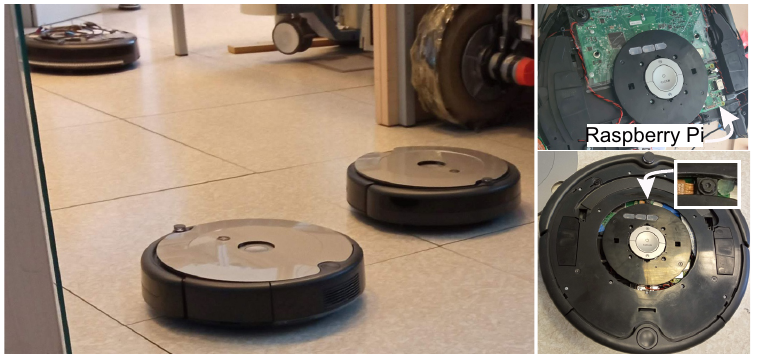
Figure 14. Roomba robots used to simulate transportation tasks in the laboratory layout from Figures 15 and 16. View of the robots (left) and closer robot view with integrated Raspberry Pi and camera